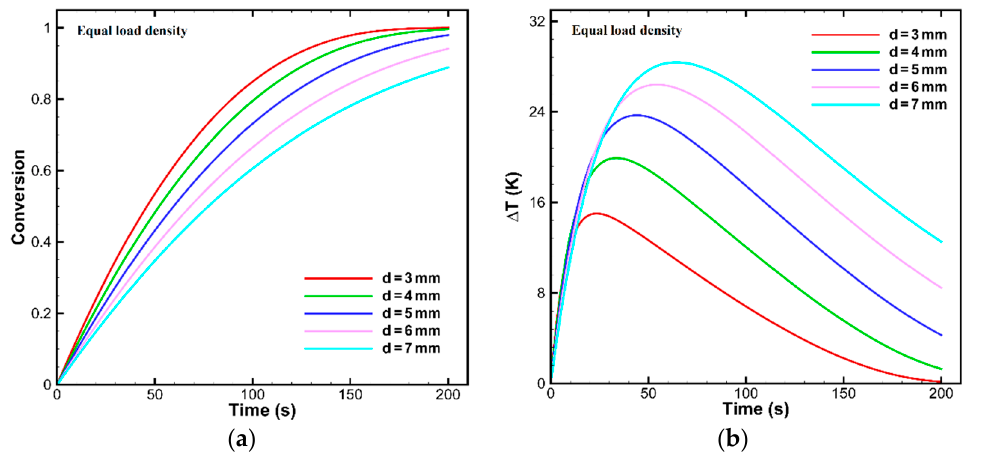
Figure 6. The profiles of ( a ) overall conversion and ( b ) ∆ T with various particle size in the equal active load density over time.